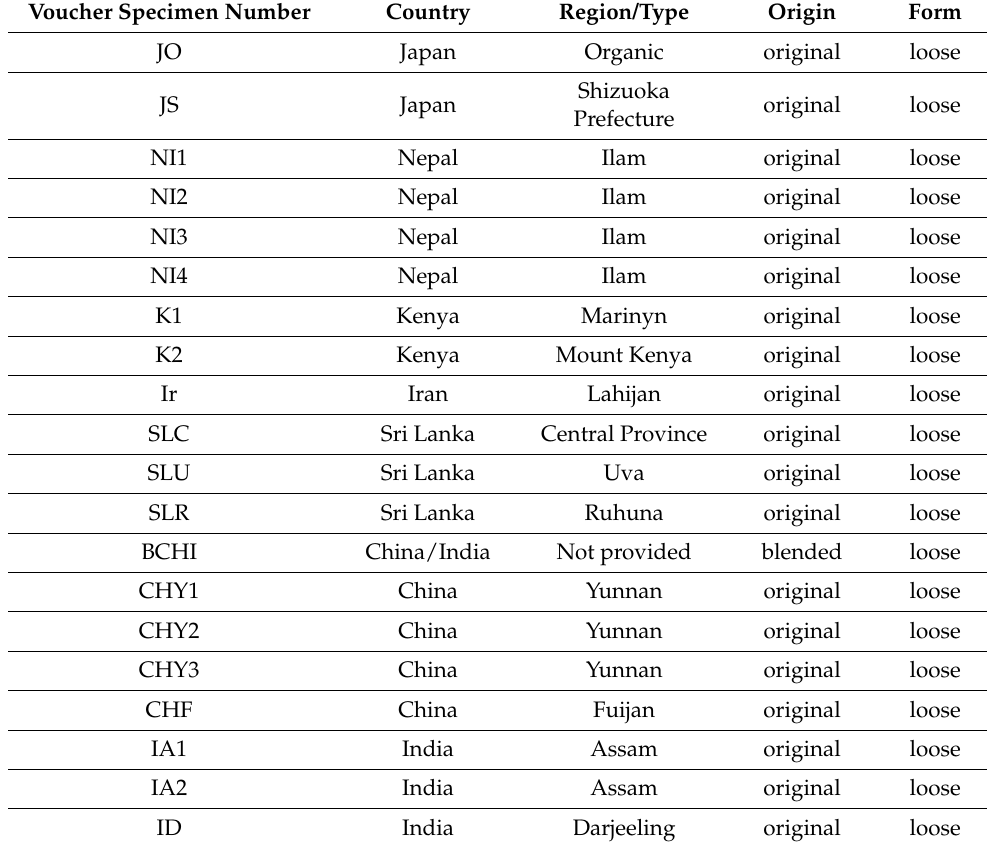
Table 3. Characteristic of the investigated black